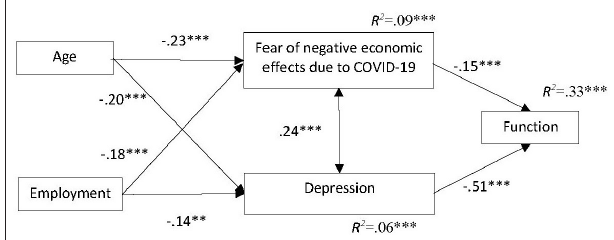
FIGURE 3 | SEM for prediction of individual function during coronavirus quarantine by age, employment, economic fear, and depression. * p < 0.05, ** p < 0.01, *** p <